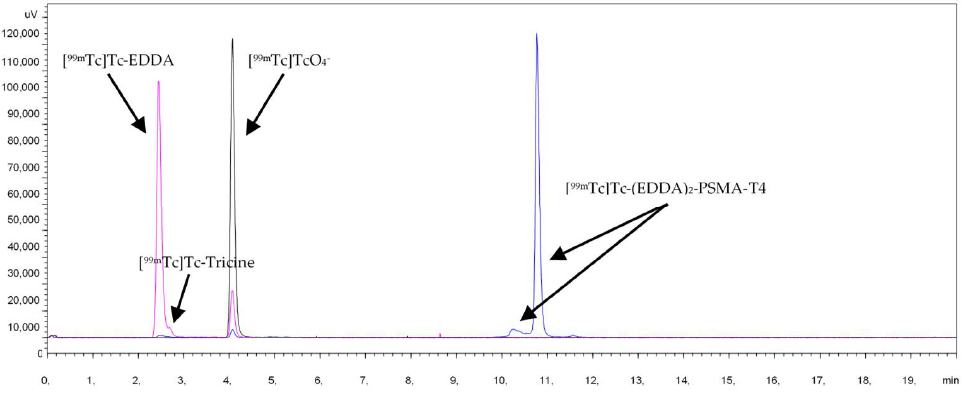
Figure 2. HPLC chromatogram of [ 99m Tc]Tc-(EDDA) 2 -HYNIC-PSMA-T4 and radiochemical impurities.